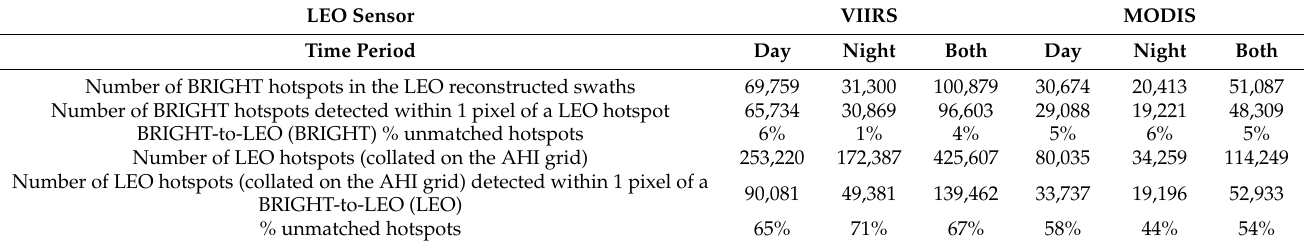
Table 1. Comparison of BRIGHT-to-VIIRS and BRIGHT-to-MODIS statistics for day, night, and day/night samples over the full